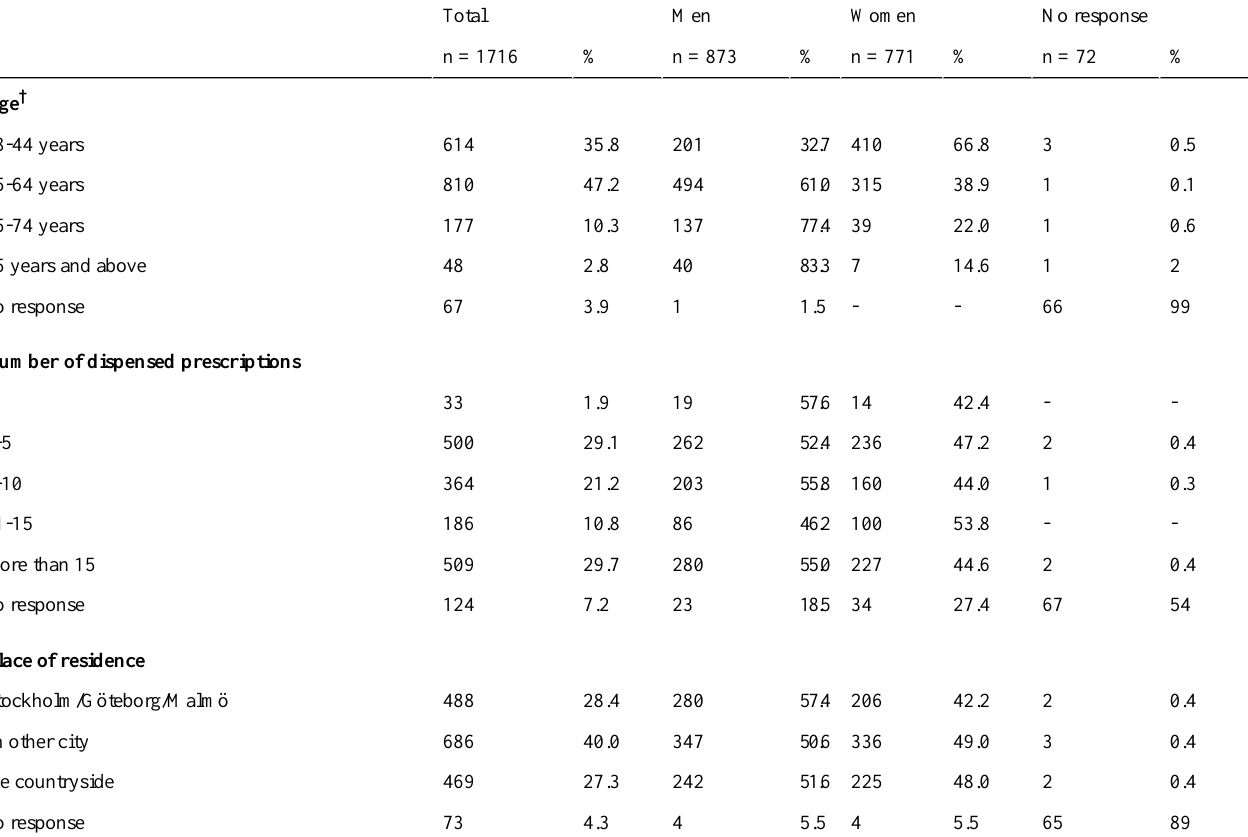
Table 3. Demographics in number (n) and percentage (%) of respondents (n = 1716) *